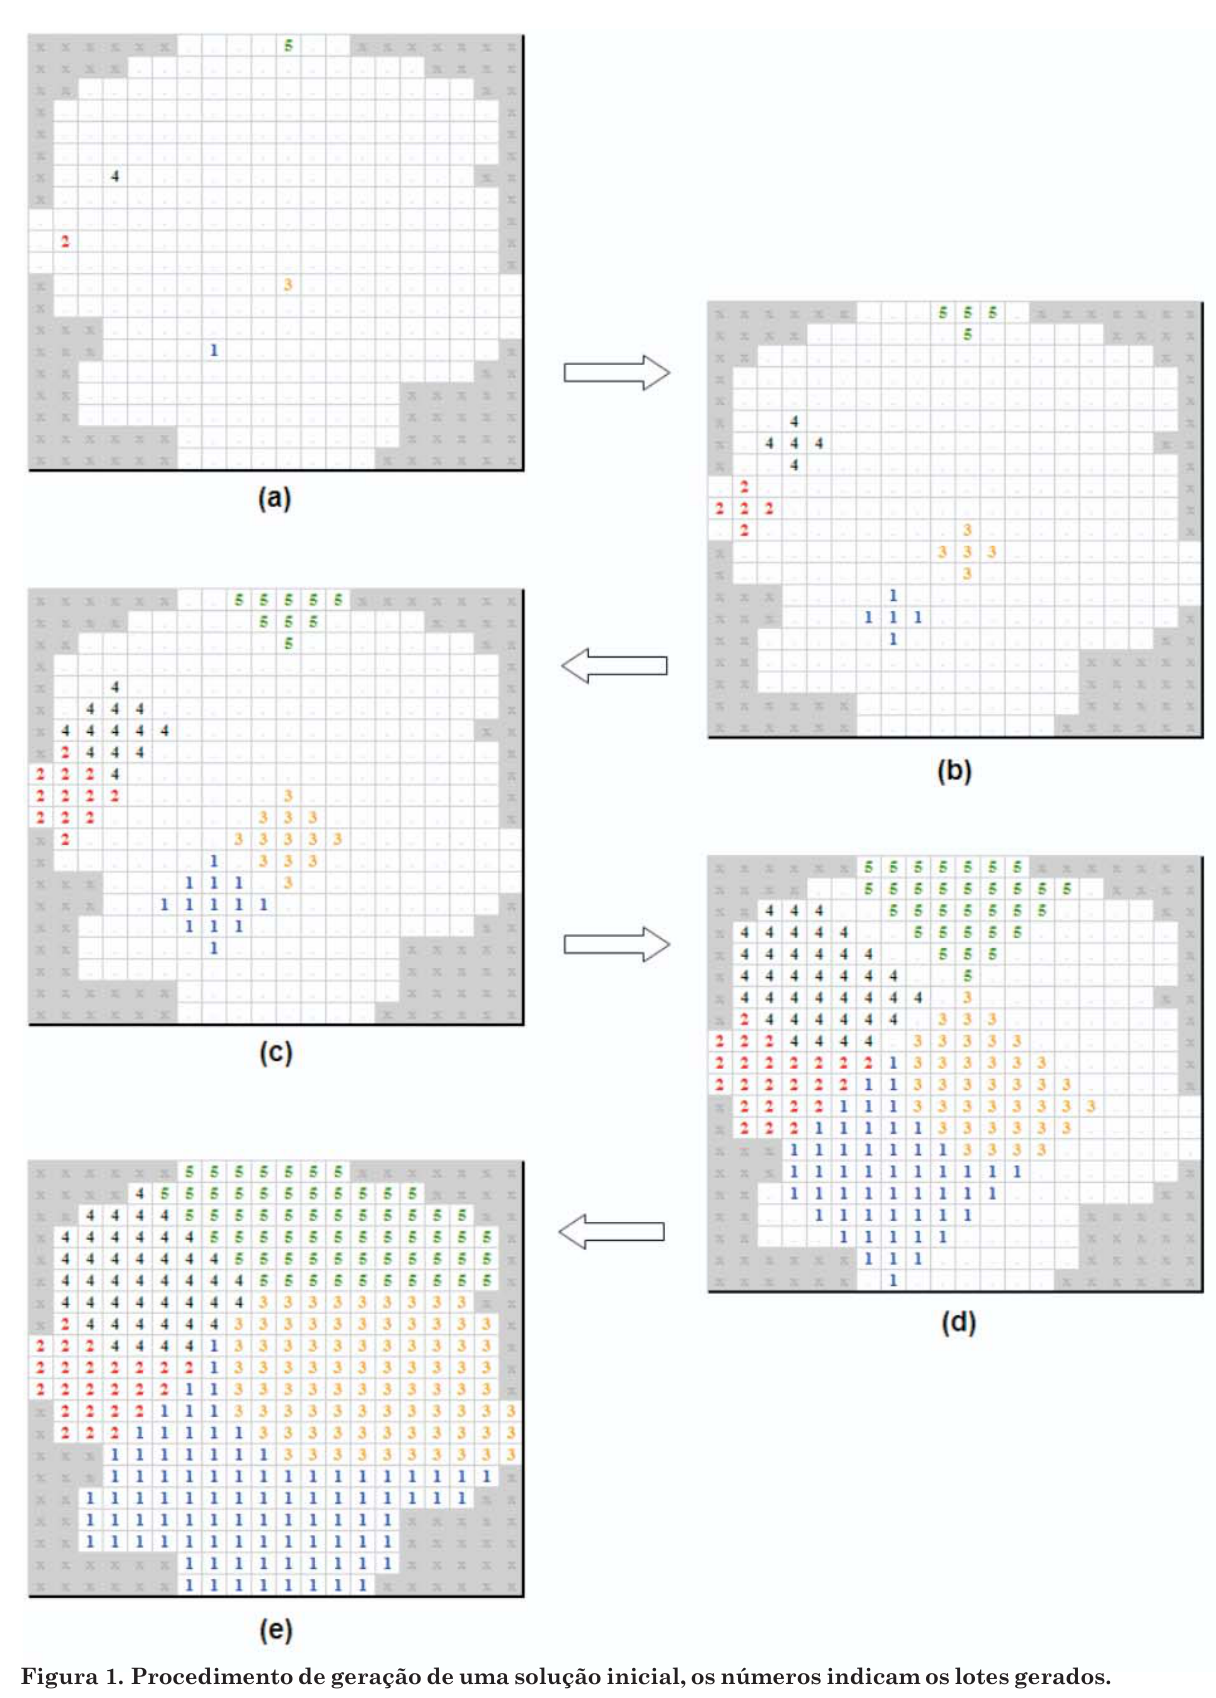
Figura 1. Procedimento de geração de uma solução inicial, os números indicam os lotes